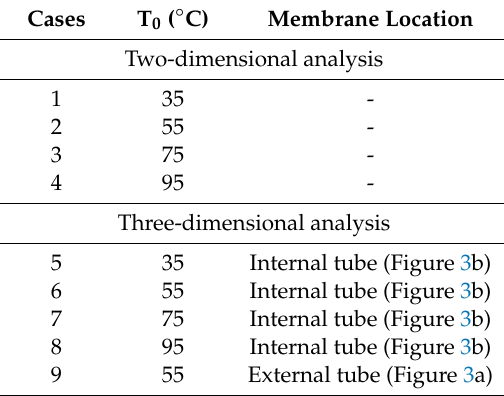
Table 6. Conditions used in the